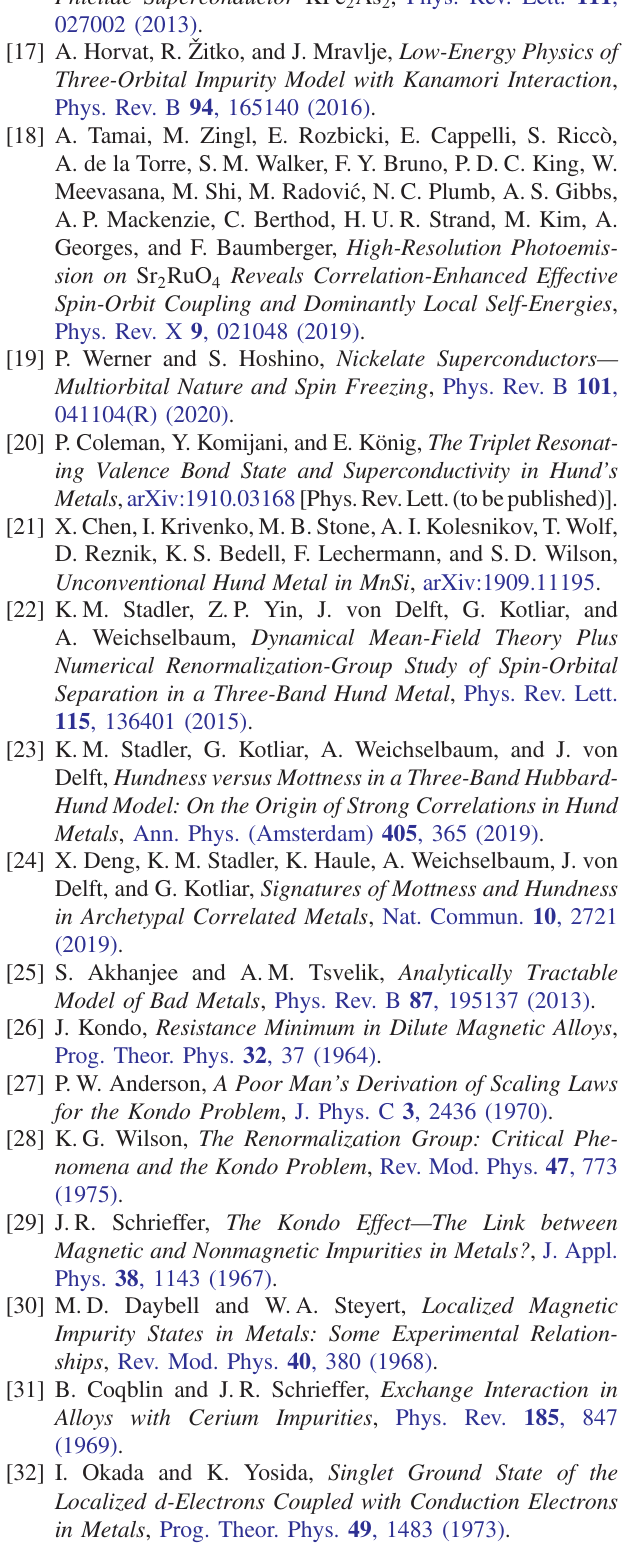
Table VI. Inthe FLregime, the spinandorbital susceptibilities ∼ ω 1 [Fig. 8(d)], as expected for a Fermi liquid scale as χ imp sp ; orb and predicted by